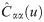
(A) Cross-correlation functions for external commands C^αα(u) (thin black line) and for network activity Cαα(u) (thick blue line) for an average pair of neurons in the same group (α ∈ {a, b, c}). Parameters are σ^=50 ms and σ = 55.76 ms. See also Fig 4B. (B) Numerically derived linear relationship σ^=Φ(σ). Blue dots are obtained from setting σ^ and deriving network synaptic equilibria. Red line shows linear the regression. Dotted black line shows the identity.